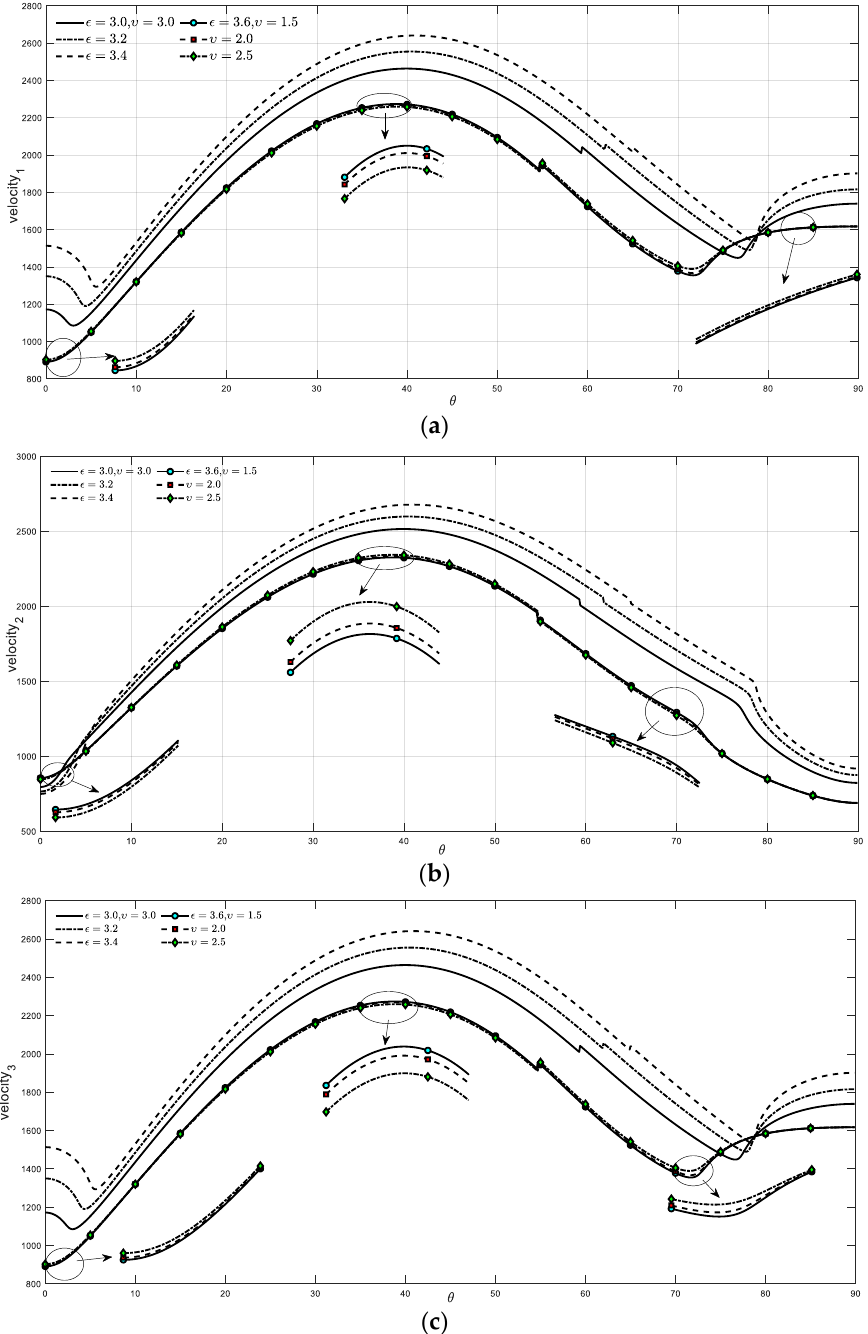
Figure 4. ( a ) Velocity 1 of wave for different angle of incidence; ( b ) Velocity 2 of wave for different angle of incidence; ( c ), Velocity 3 of wave for different angular frequency.